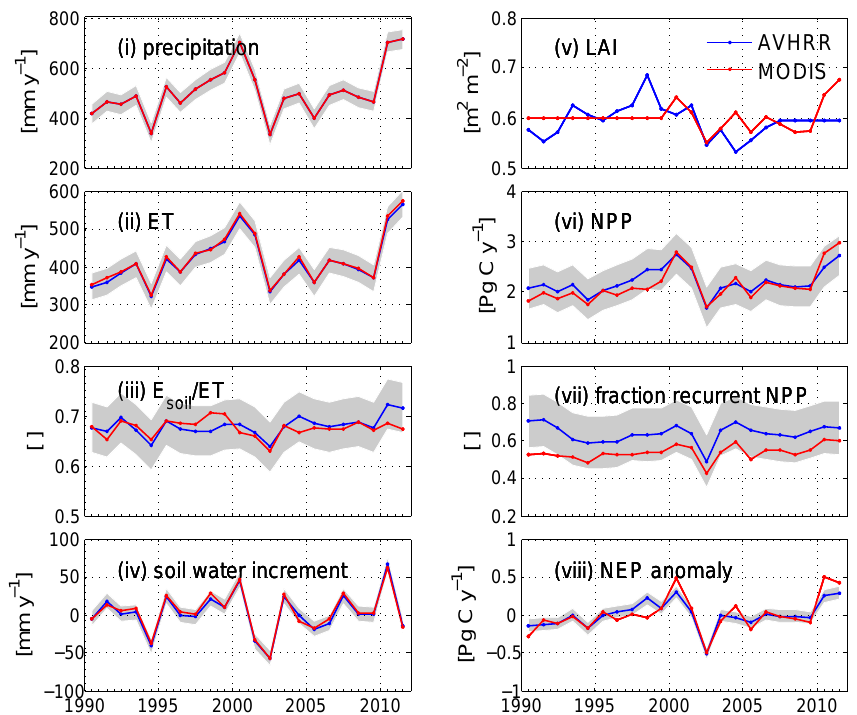
Fig. 18. Annual time series (1990-2011) of continental area-averaged (i) precipitation; (ii) ET; (iii) E soil /ET; (iv) increment in soil water column; (v) LAI (derived from MODIS and AVHRR fPAR); (vi) NPP; (vii) fraction of NPP from recurrent (mainly grassy) vegetation; and (viii) net ecosystem productivity anomaly (or carbon stock increment relative to mean increment over 1990–2011 period). Shading indicates the 1- σ uncertainty arising from parameter and forcing uncertainties. Blue and red lines denote results derived using LAI from AVHRR fPAR and MODIS fPAR,